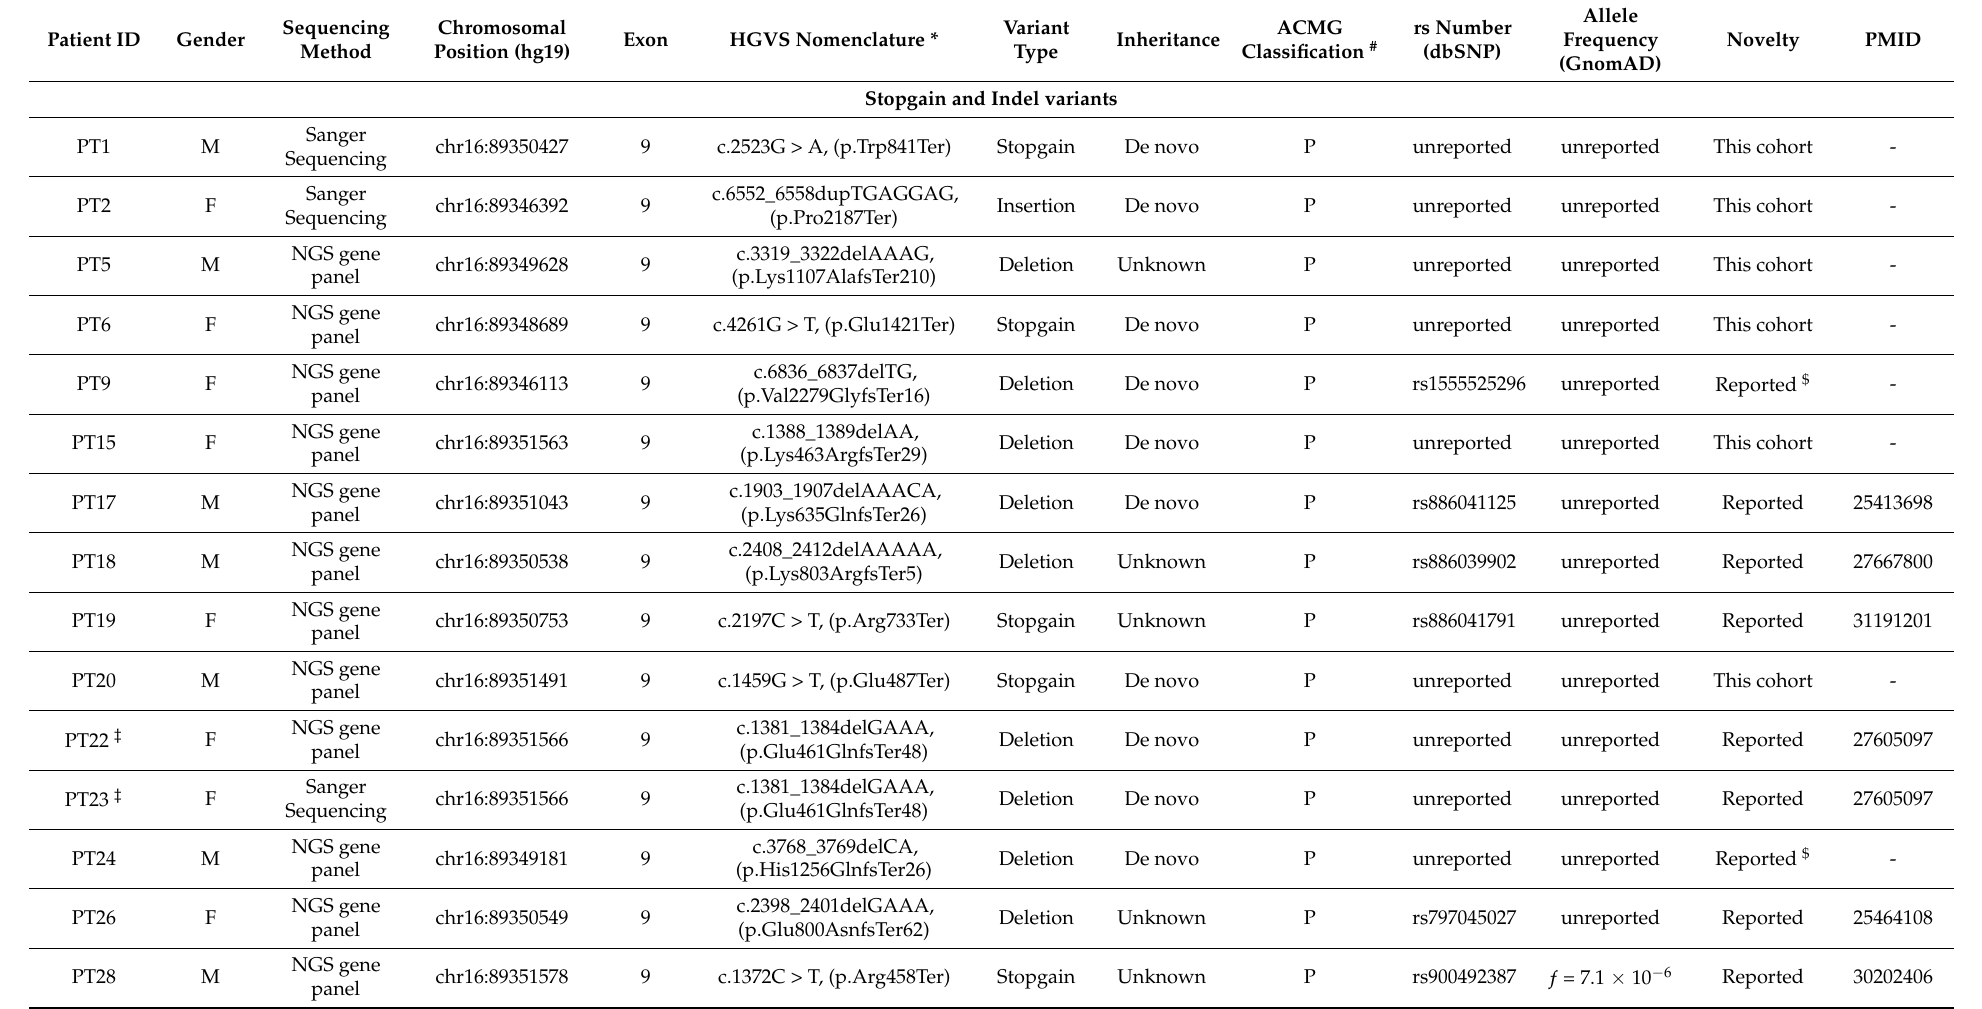
Table 1. Variants identified through ANKRD11 sequencing in KBG